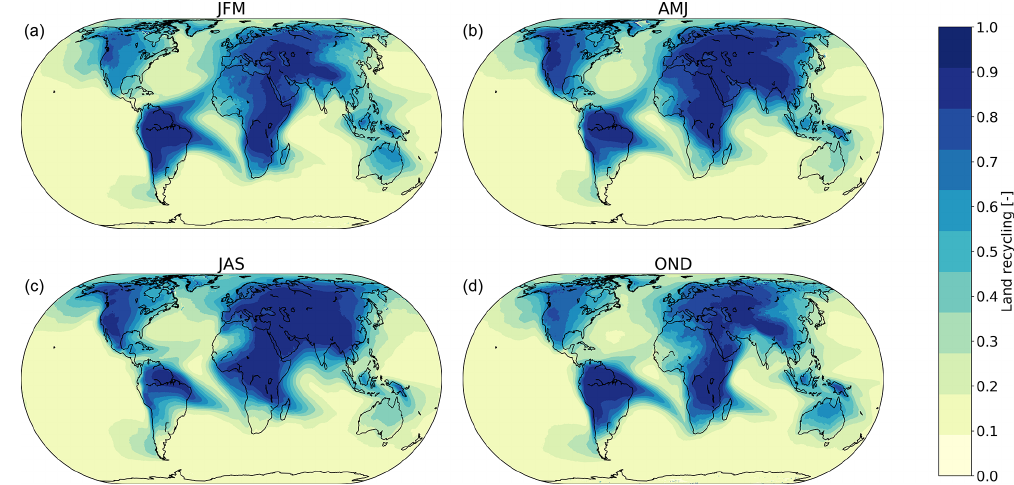
Figure 2. Seasonal variability of evaporation recycling ratio (as a fraction) over land. Evaporation recycling ratio is the fraction of evaporation that subsequently rains down over land. (a) January through March. (b) April through June. (c) July through September. (d) October through